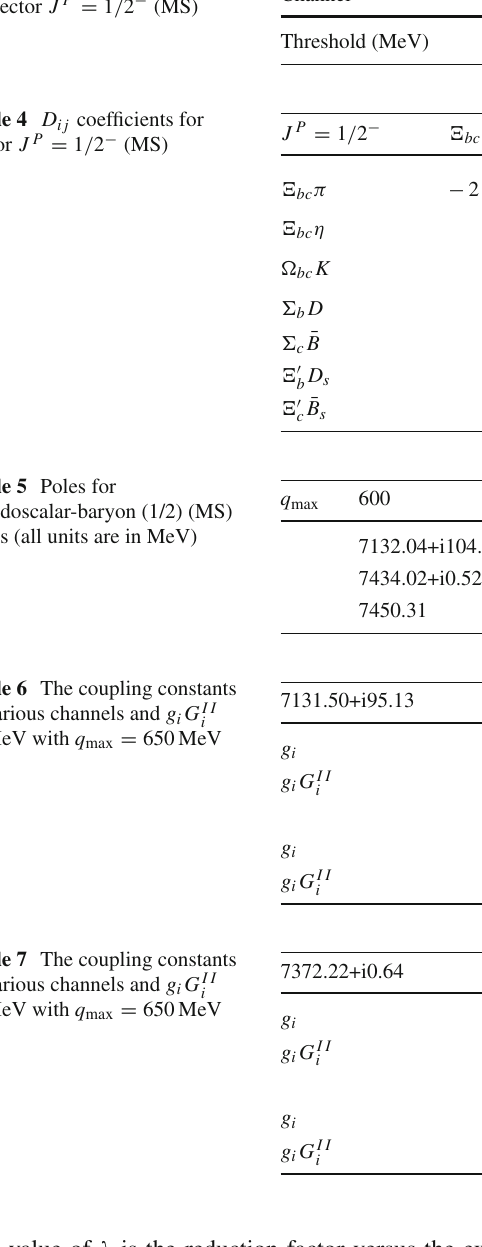
for sector J P = 1 / 2 − (MS)